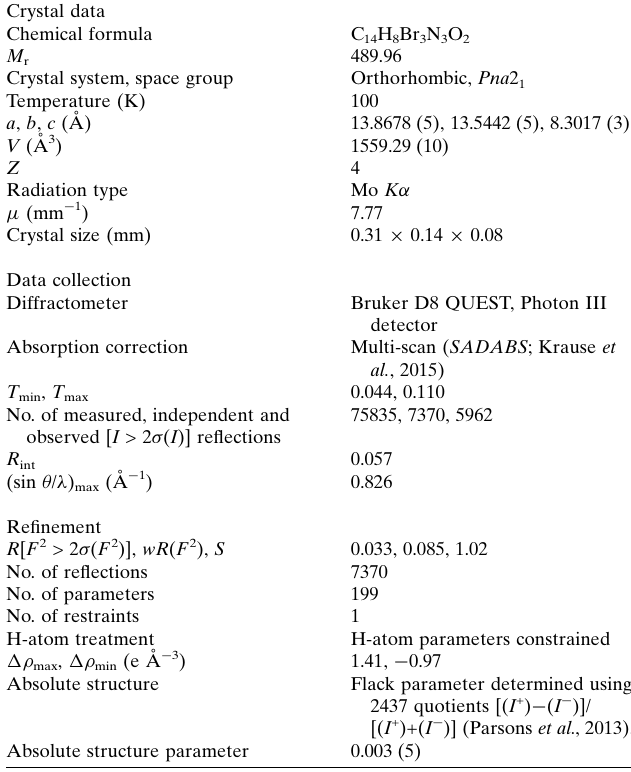
Table 3 Experimental